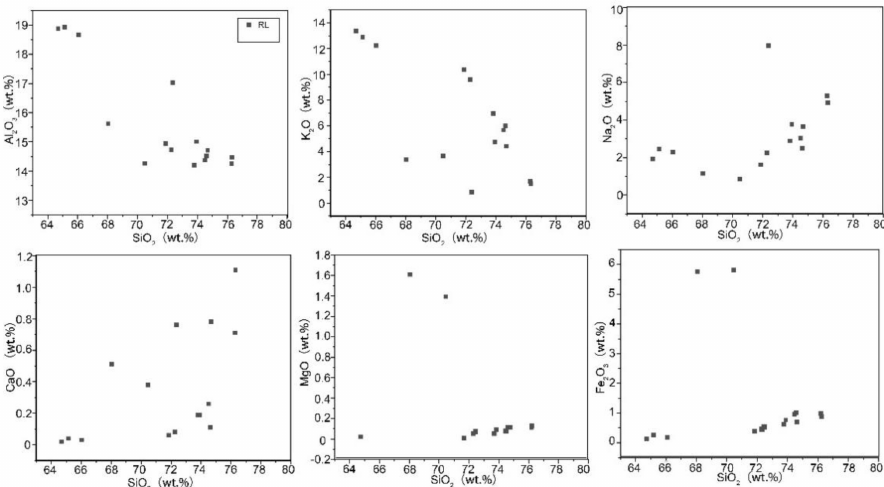
Figure 6. Variation diagram of Al 2 O 3 , K 2 O, Na 2 O, Cao, MgO, and Fe 2 O 3 content versus the SiO 2 content. The chondrite- and primitive-mantle-normalized REE [36] and trace element